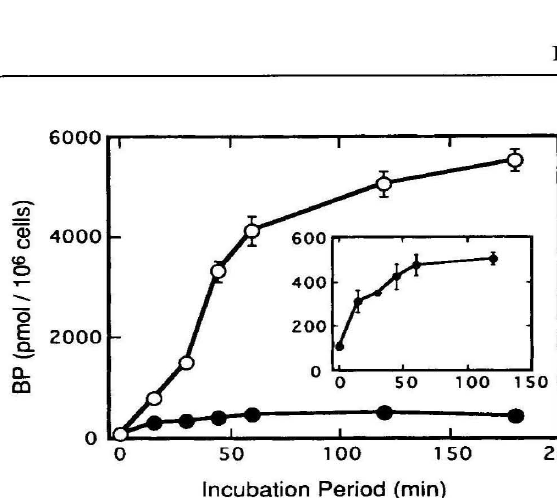
Figure 1. Time dependent incorporation of sepiapterin and tetrahydrobiopterin by RBL2H3 cells in culture: RBL2H3 cells were given 50 ~M sepiapterin (circles) or tetrahydrobiopterin (dots). At the indicated times, cells were washed 3 times with PBS then subjected to acid oxidation with iodine for measuring biopterin (n=5). In set: the same data for tetrahydrobiopterin were replotted in expanded scale. (n=5)